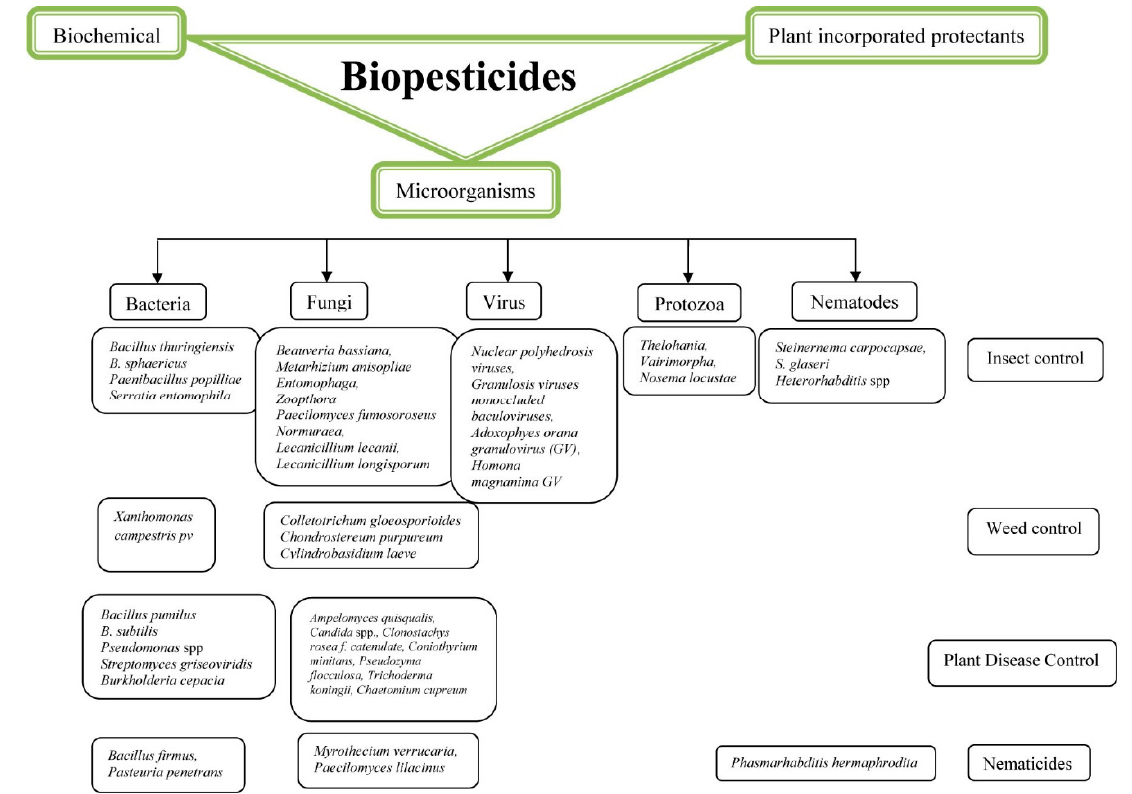
Figure 3. Biopesticides classification and involving microorganisms. Table 6. Microbial-based biopesticides.